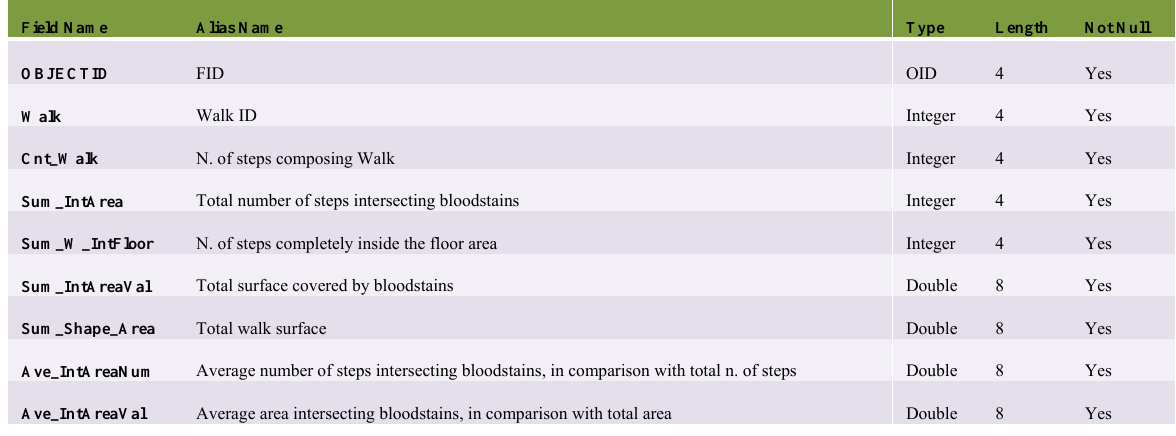
Table 2. Walk attributes and their description.